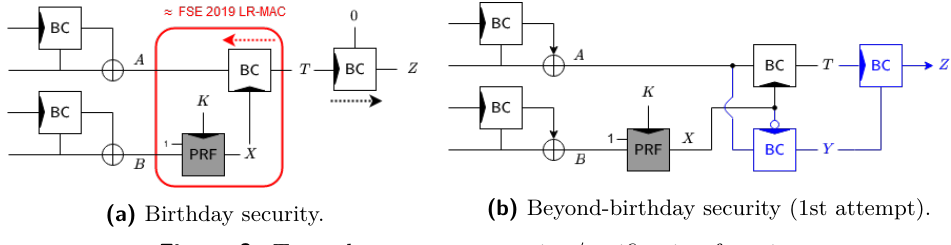
Figure 9: Towards our tag generation/verification